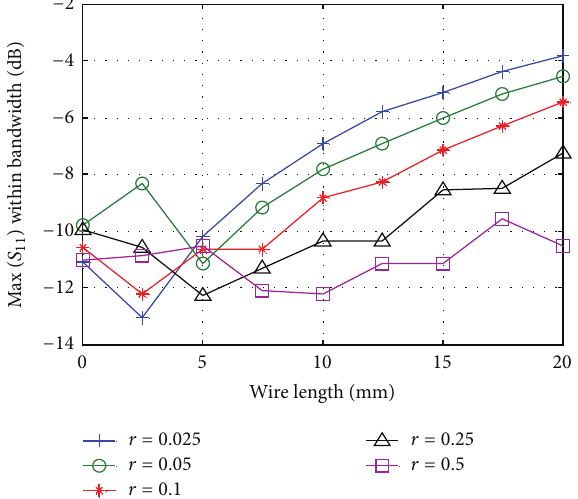
Figure 12: Simulated maximum reflection coefficient within the specified bandwidth from 920 to 926MHz for different wire lengths 𝑙 and radius 𝑟 .